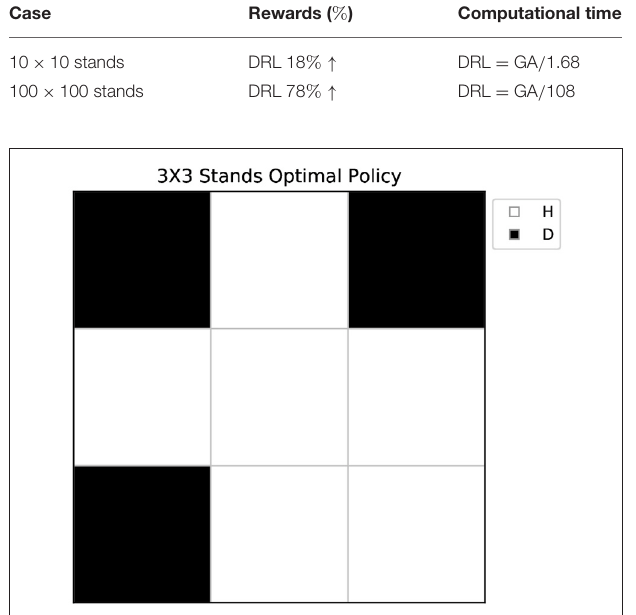
FIGURE 10 | The optimal policy of the 3